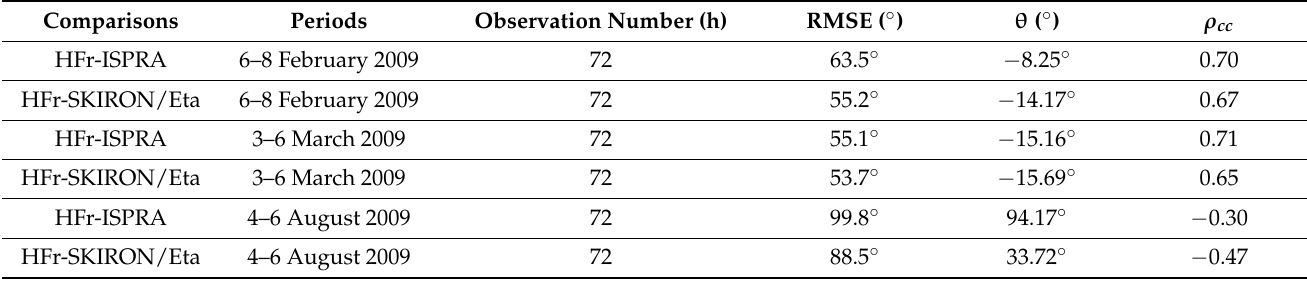
Table 2. Statistical skill metrics (RMSE, θ and ρ cc ) of the comparisons between HFr, ISPRA weather station and SKIRON/Eta model related to the selected events: 6–8 February 2009, 3–6 March 2009 and 4–6 August